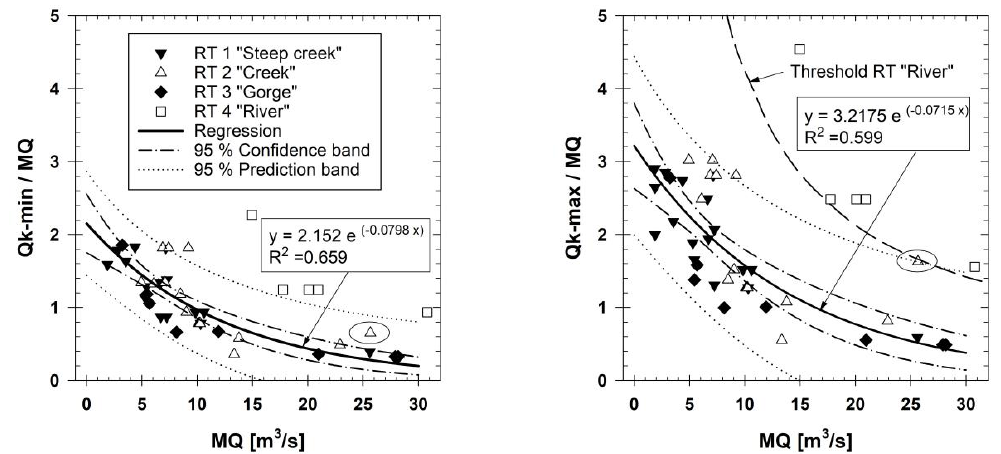
Figure 8. Ratio Qk/MQ as function of the unregulated mean discharge MQ (1961–1990) for the minimum kayak flow Qk-min ( left ) and maximum kayak flow Qk-max ( right ), specified for the four RTs. The regression functions were derived without including RT 4 “river” and the run marked with an ellipse, see explanations in text.